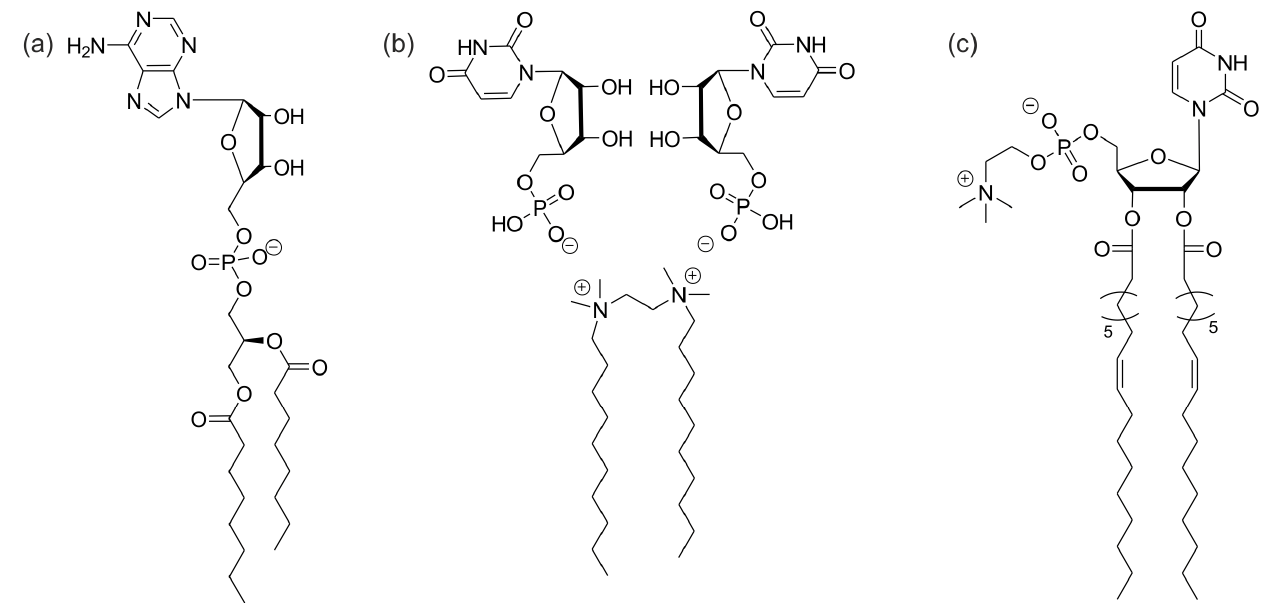
Figure 3. Examples of nucleoside amphiphiles; ( a ) diC nucleotide [39]; and ( c ) a zwitterionic